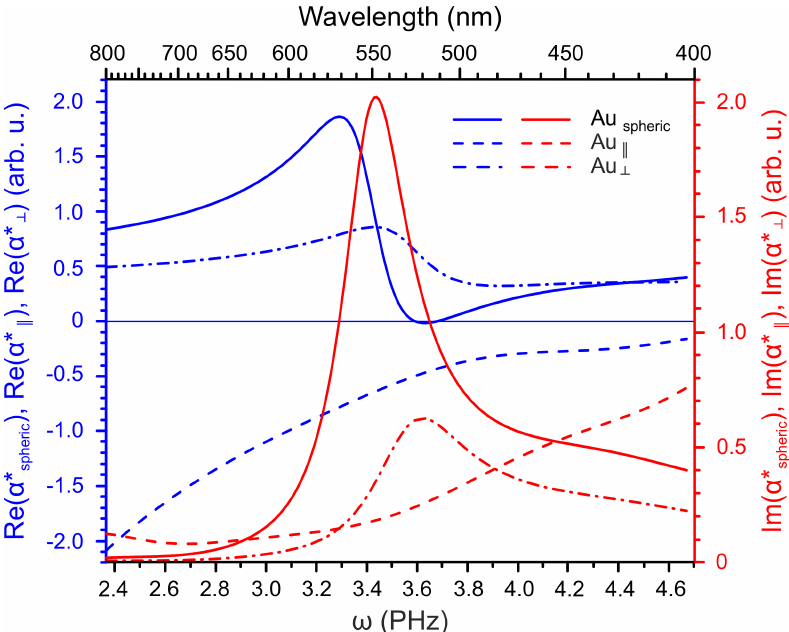
Figure 2. Frequency dependence of real and imaginary parts of the components of the effective polarizability of gold NPs Re ( α ∗ (cid:107) ) , Im ( α ∗ (cid:107) ) , Re ( α ∗ ⊥ ) and Im ( α ∗ ⊥ ) in the nematic host 5CB.